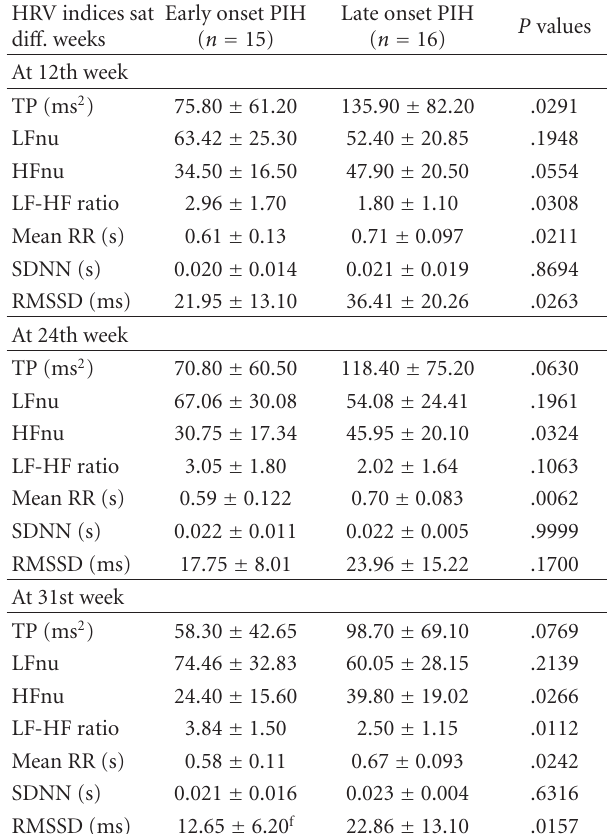
Table 4: Comparison of HRV indices between early-onset PIH and late-onset PIH at di ff erent weeks of gestation. HRV indices sat di ff . weeks